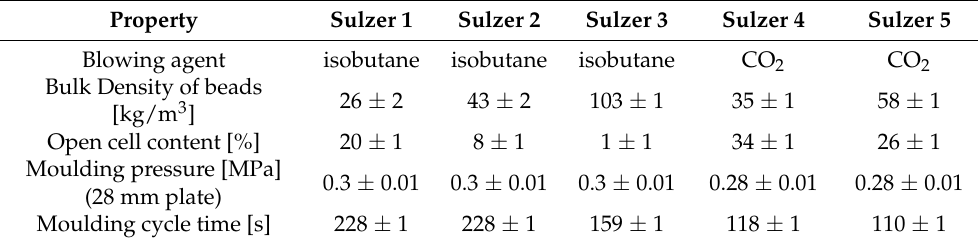
Table 1. Steam chest molding conditions and density of the molded